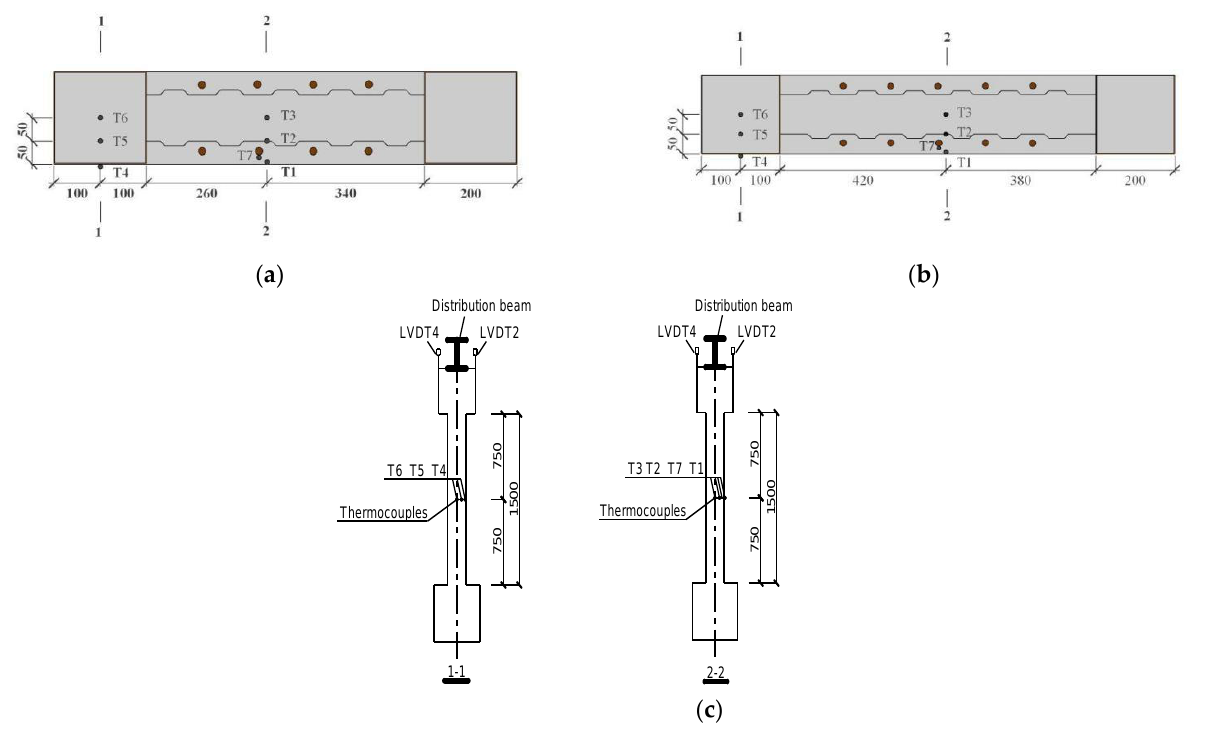
( c ) Figure 9. Patterns of specimen after fire. ( a ) SW2; ( b ) SW3; ( c ) SW4.